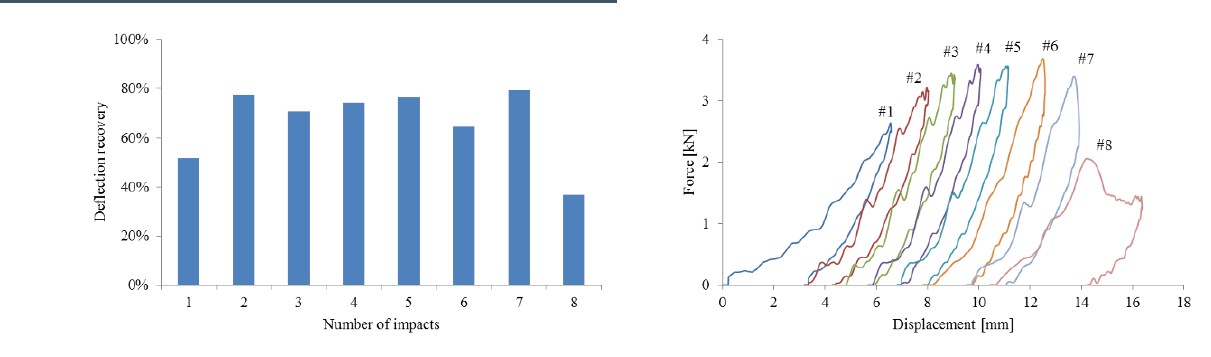
a large mass before first cracking at impact #6. Two more impacts were necessary to reach the penetration